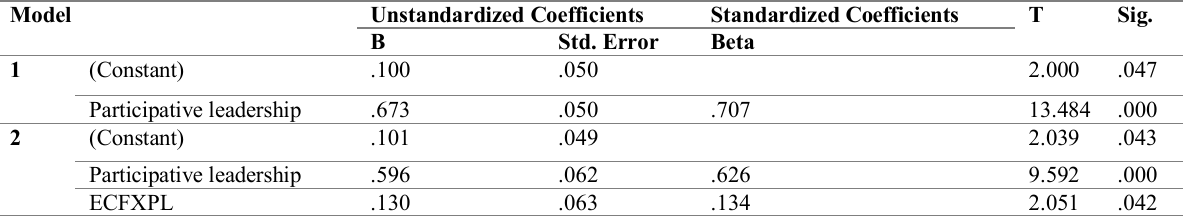
Table 5: Regression coefficients for participative leadership